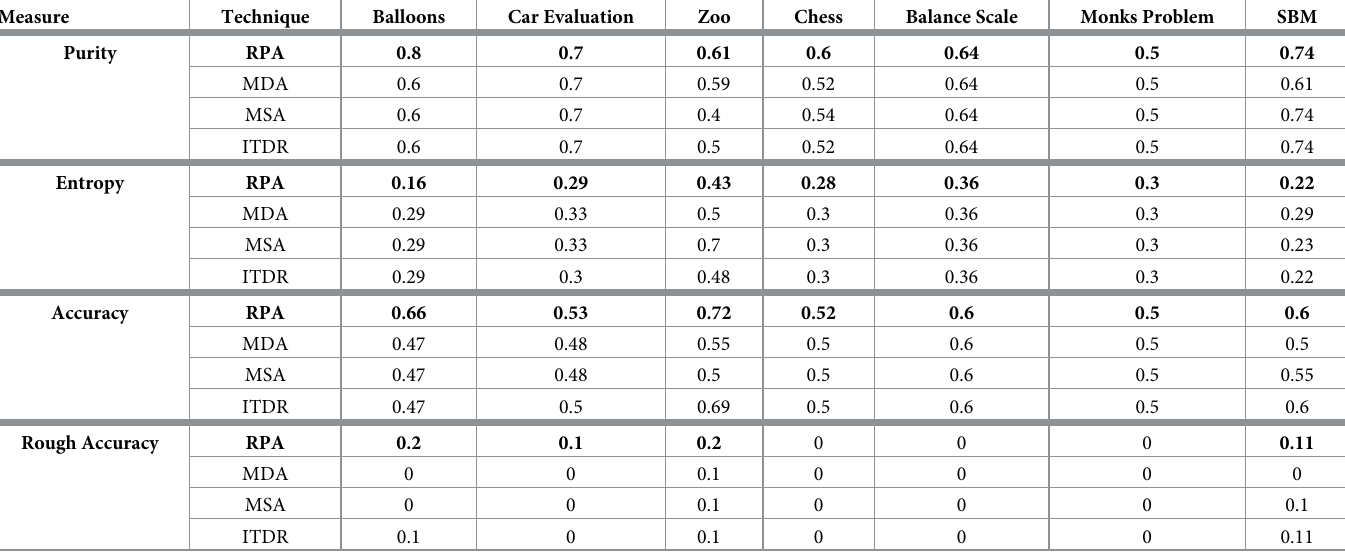
Table 13. Comparative performance of techniques for all data sets.